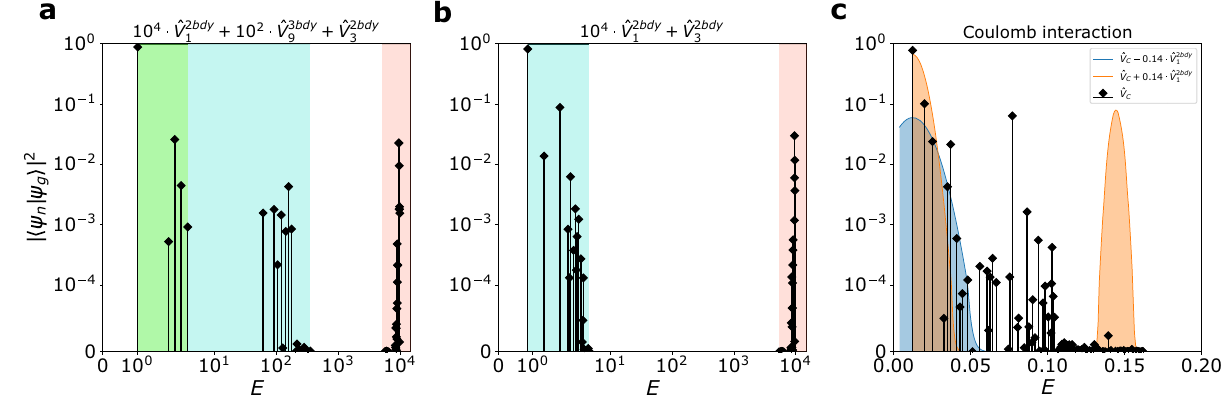
Fig. 4 | Spectral functions of the FQH state at ν =2/9 with 8 electrons. a Model Hamiltonian. Two peaks within H 2bdy 1 can be seen in the spectral function, where the green, the turquoise, and the red sector denotes the null space of ^ V 3bdy 9 , H 2bdy 1 and the complement of H 2bdy 1 . b Model Hamiltonian without ^ V 3bdy 9 . The two peaks within H 2bdy 1 merge after ^ V 3bdy 9 is removed from the Hamiltonian. These graviton modes have the same chirality because the FQH state at ν =2/9 has no PH con- jugation in any of the CHSs. A slightly exaggerated ratio between different PPs is